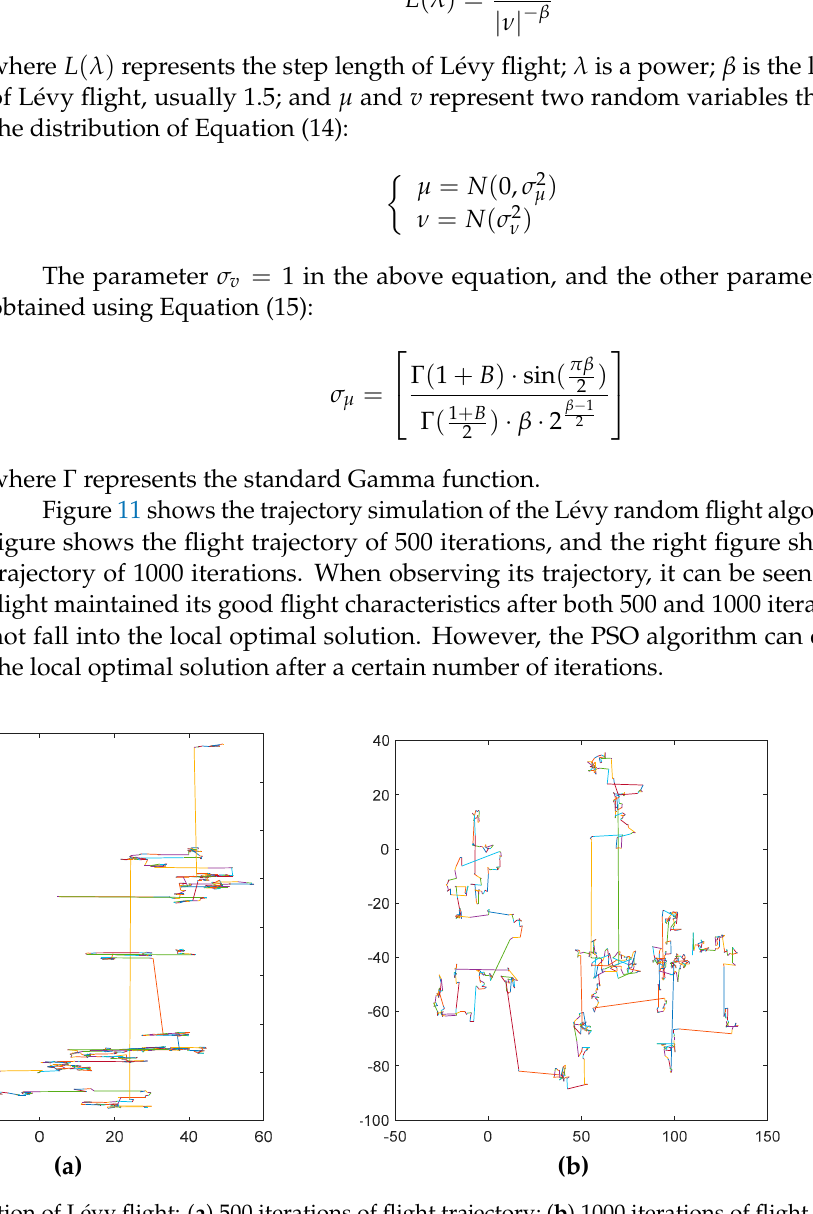
Figure 11. Trajectory simulation of Lévy flight: ( a ) 500 iterations of flight trajectory; ( b ) 1000 iterations of flight trajectory.